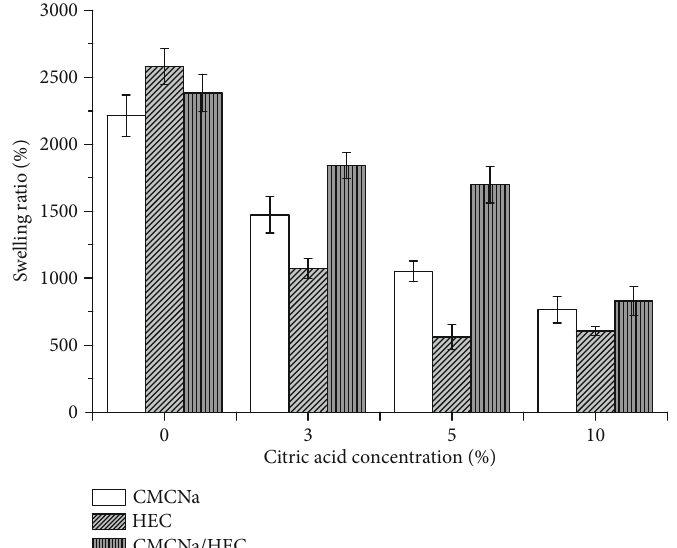
Figure 1: Hydrogel swelling capacity (%) of CMCNa, HEC, and CMCNa/HEC whey hydrogel (3% wt) in distilled water. The bar graph shows the dependence of water absorption (g/g) on CA concentration (3, 5, and 10% wt).